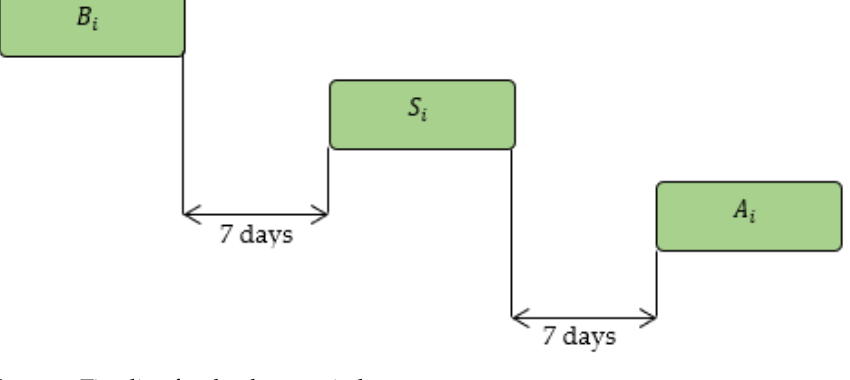
Figure 3. Timeline for the three periods.